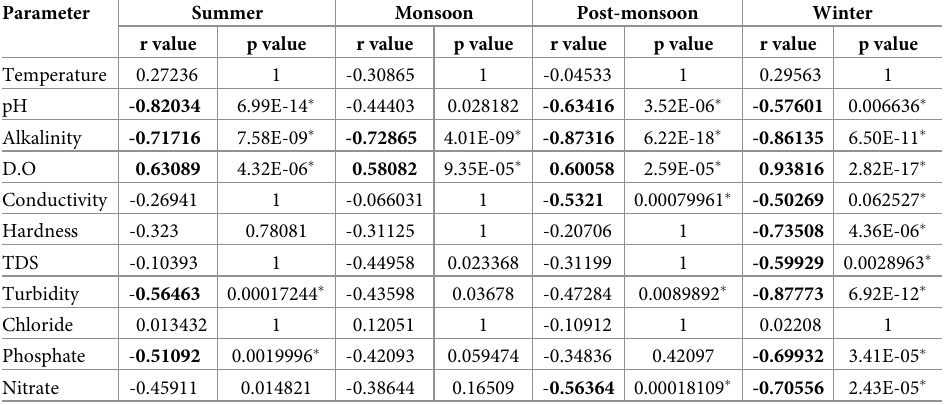
The values given here are Pearson’s correlation (r) and significance level (p). Values (r) in bold and asterisk ( � ) above a given value (p) indicates significant correlation at p = < 0.01 after Holms- Bonferroni